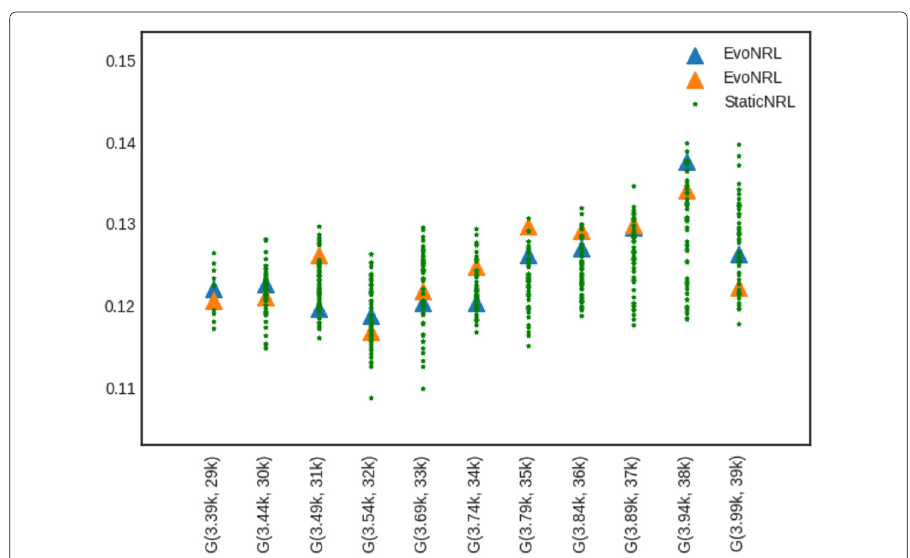
Fig. 15 Accuracy values obtained by running StaticNRL multiple times on the same network. The values are significantly fluctuating due to sensitivity to the set of random walks obtained. Similarly, E VO NRL is sensitive to the initial set of random walks obtained. Two instances of E VO NRL are shown, each of which operates on a different initial set of random walks